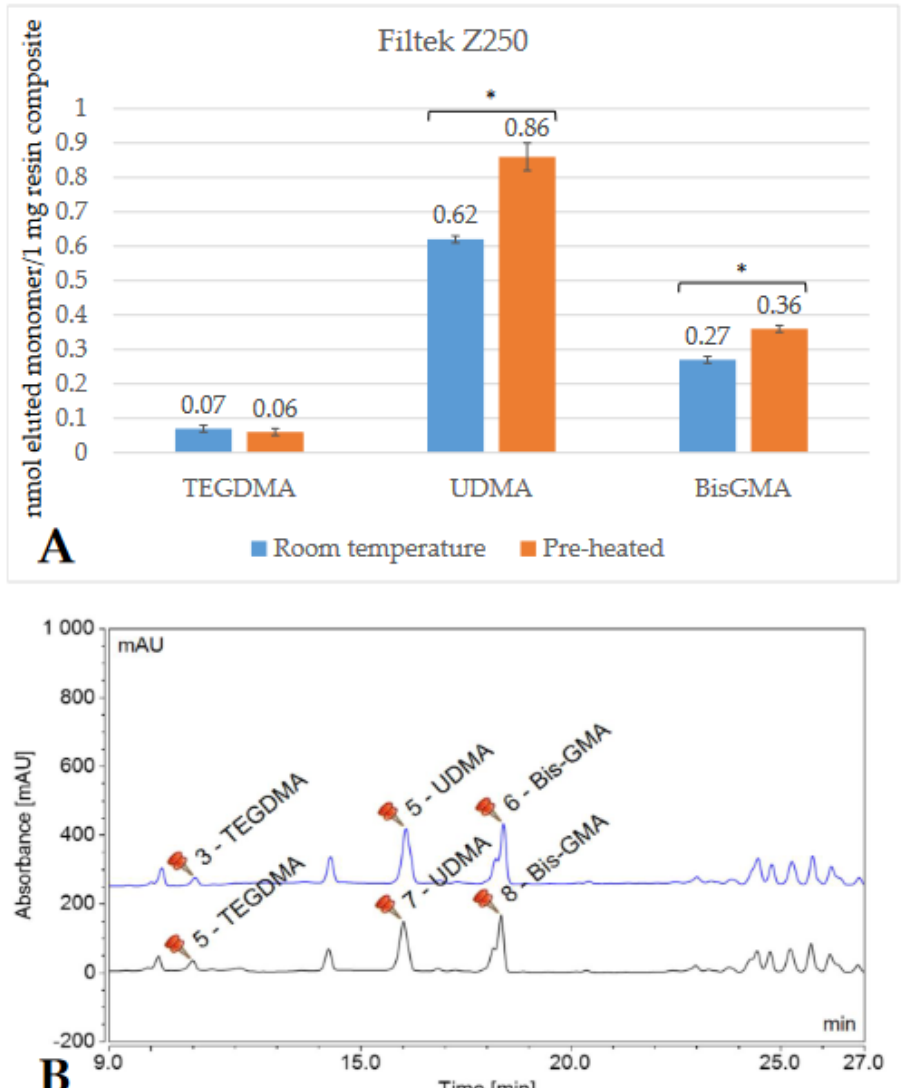
Figure 5. Comparison ( A ) of the amount of eluted monomers from room-temperature (blue bars) and pre-heated (orange bars) Filtek Z250 samples. The * mark indicates statistically significant differences between the groups according to the independent two-tailed t -test. The chromatogram ( B ) shows the detected monomers eluting from room-temperature (black chromatogram) and pre-heated (black chromatogram) Filtek Z250 and their retention times based on the standard monomers, evaluated at a 205 nm wavelength. (Abbreviations: TEGDMA, trietylene-glycol-dimethacrylate; UDMA, urethane-dimethacrylate; BisGMA, bisphenol A-glycidyl methacrylate; mAU, milli-Absorbance Units).